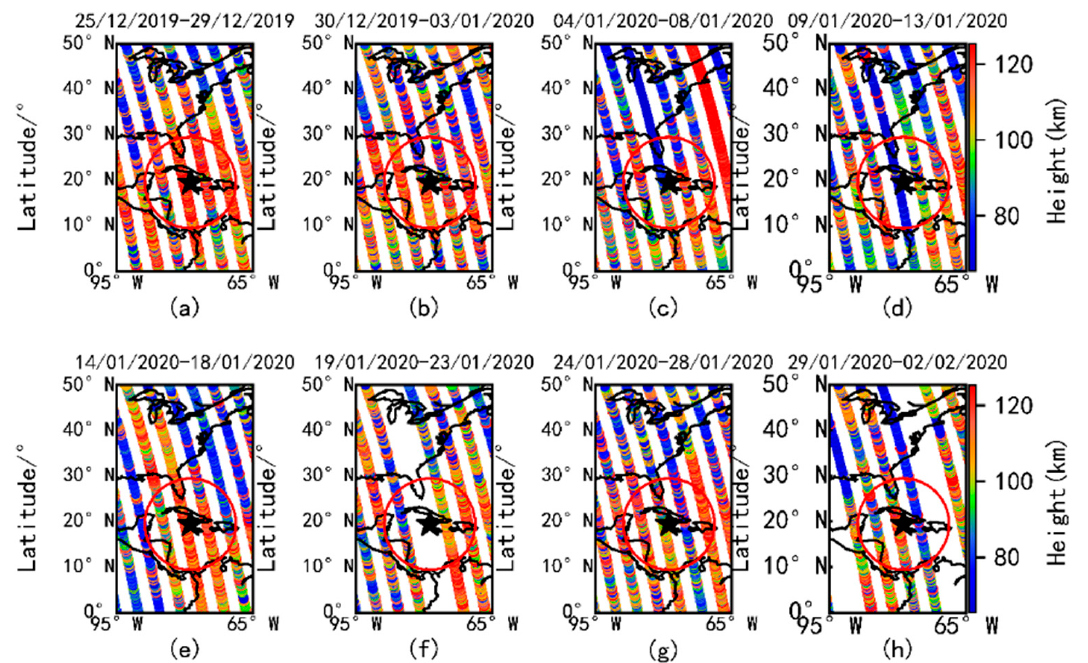
Figure 10. The space–time diagram of the height of the lower ionosphere observed by the CSES (the black star indicates the epicenter location and the red circle indicates the seismogenic zone. ( a – h ) represents the total eight cycles of satellite operation from 25 December 2019 every 5 days to 2 February 2020).